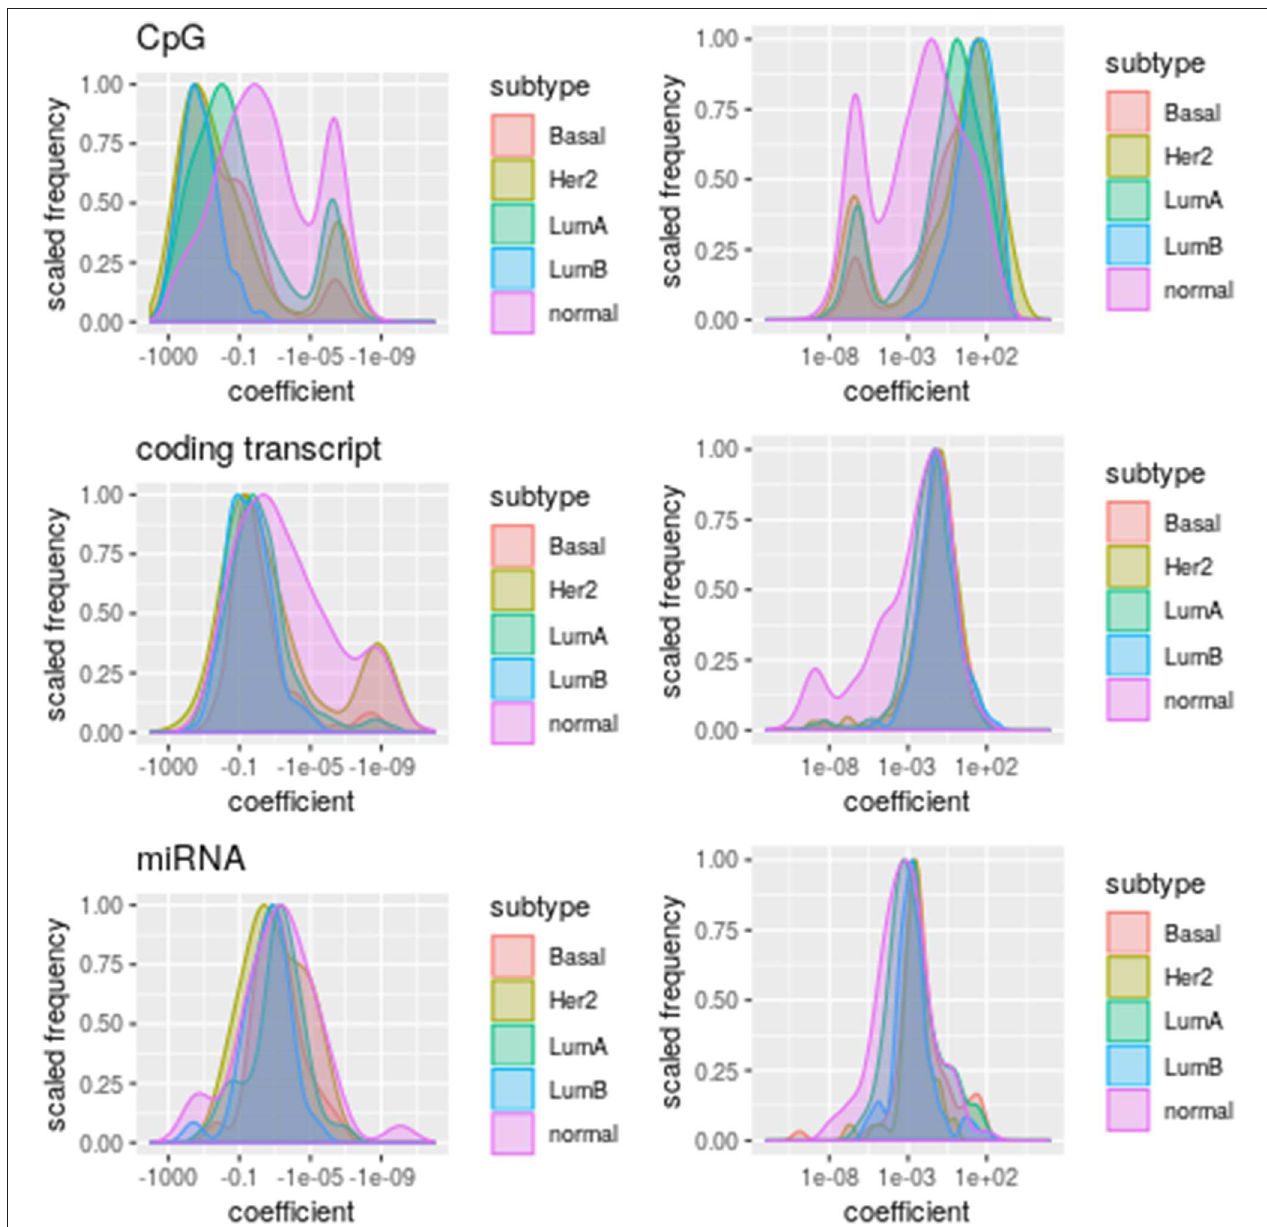
FIGURE 4 | Distribution of coefficient values per omic. The subtypes are represented by different colors. Plots at the (Left) column represent negative coefficients whereas those at the (Right) column stand for positive coefficient values.